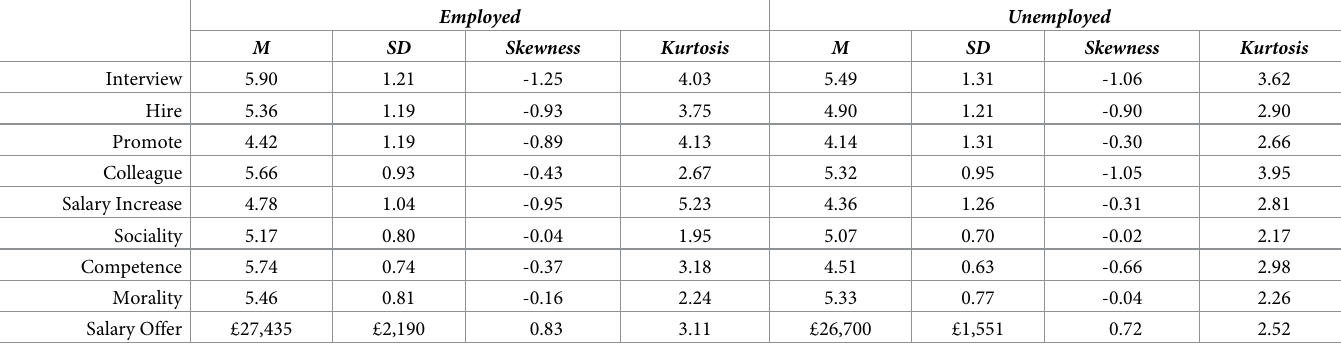
Table 1. Descriptive statistics for dependent variables as a function of